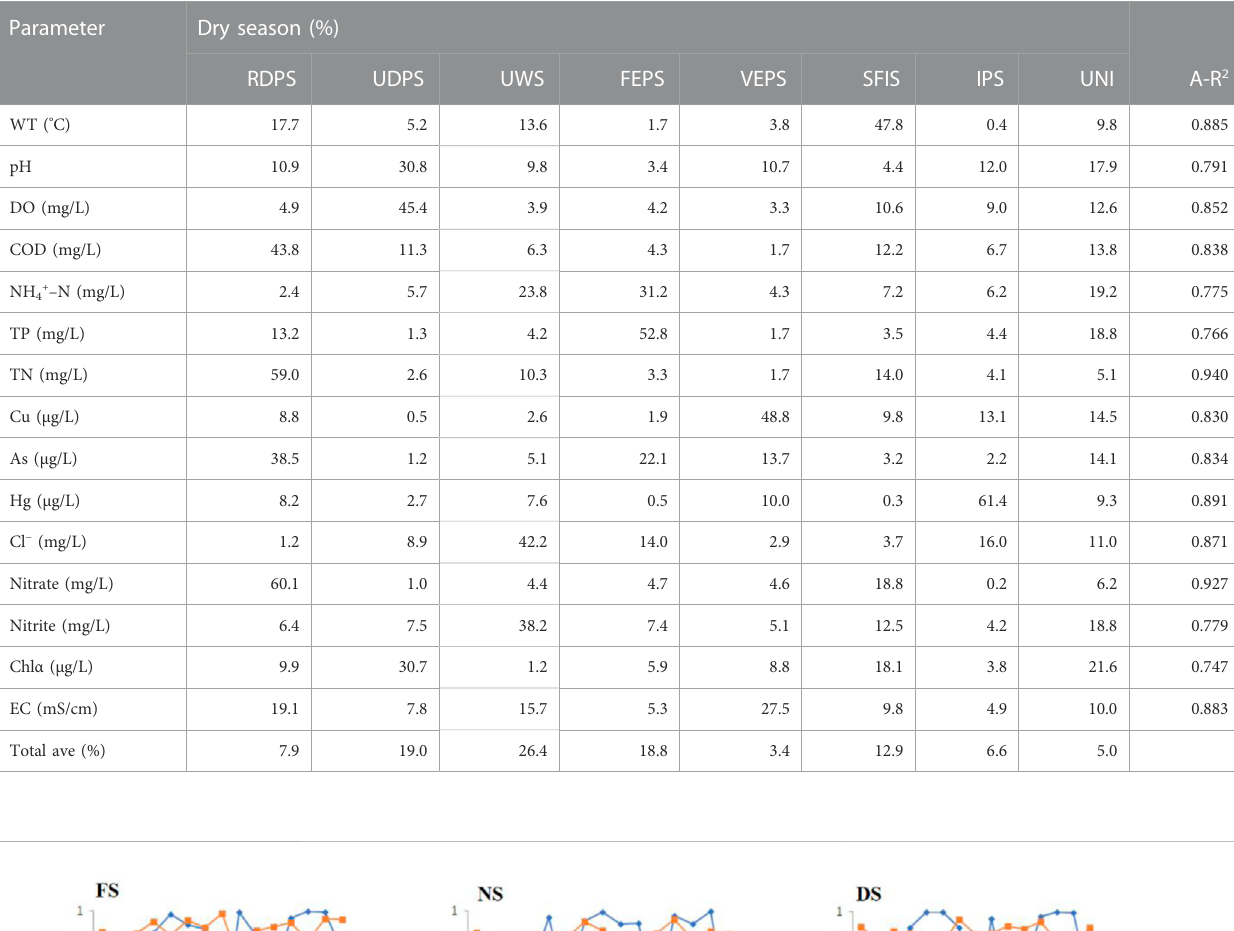
TABLE 5 Contribution of pollution sources for each pollutant in the dry season with PCA/FA results. Parameter